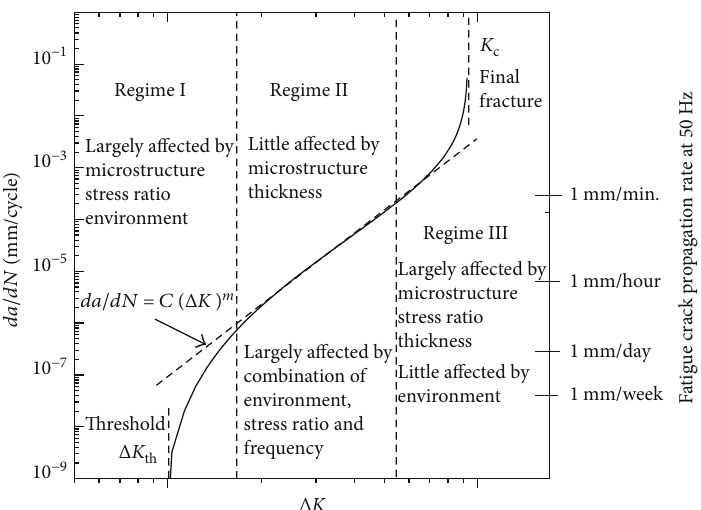
Figure 1: The typical fatigue crack growth rate with regard to the stress intensity factor curve for metallic materials, which is distinguished by three regimes. The corresponding in fl uence factors and the crack propagation velocity at 50 Hz under di ff erent levels of the fatigue crack growth rate are also illustrated